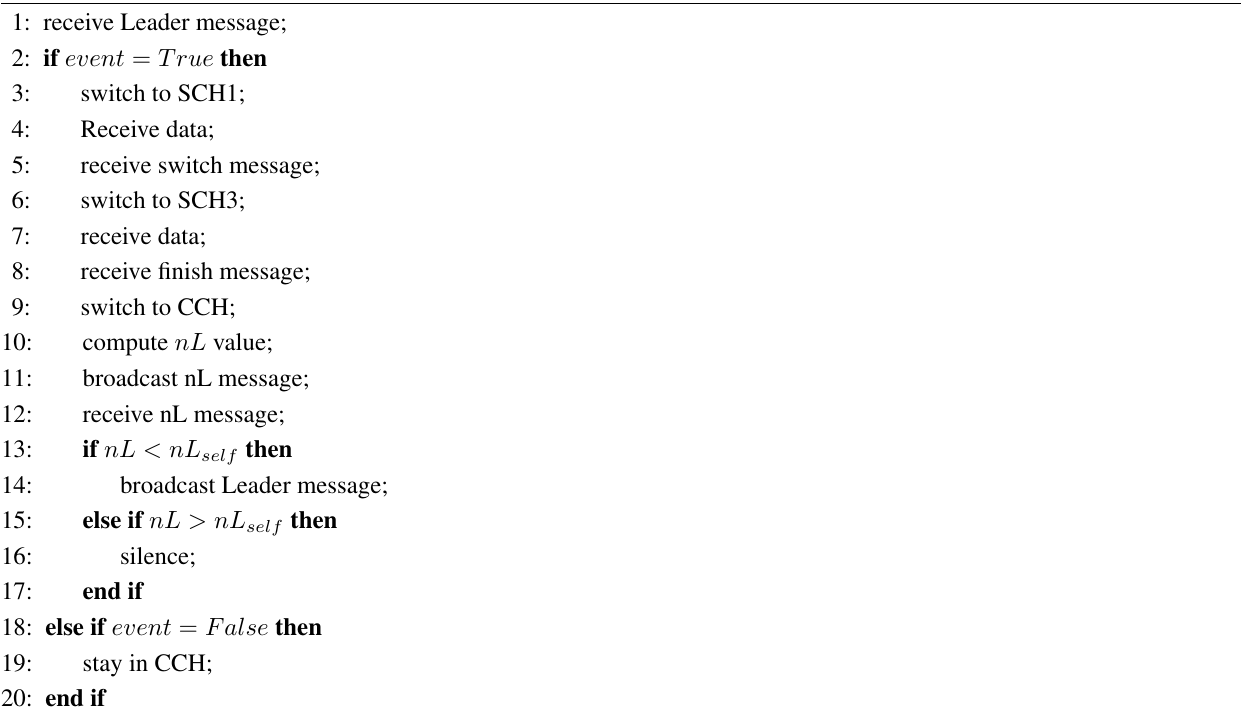
Algorithm 4 Next Leader competition for the No Data